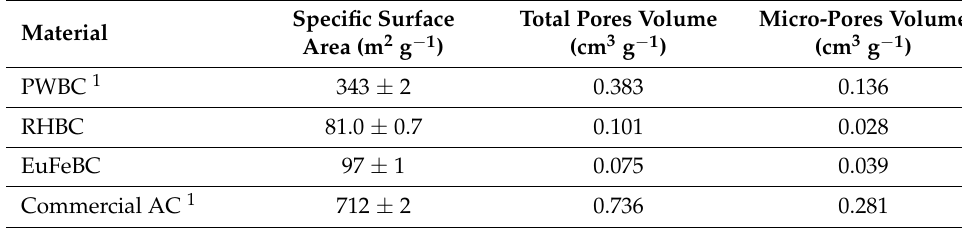
Table 1. Results of textural characterization.